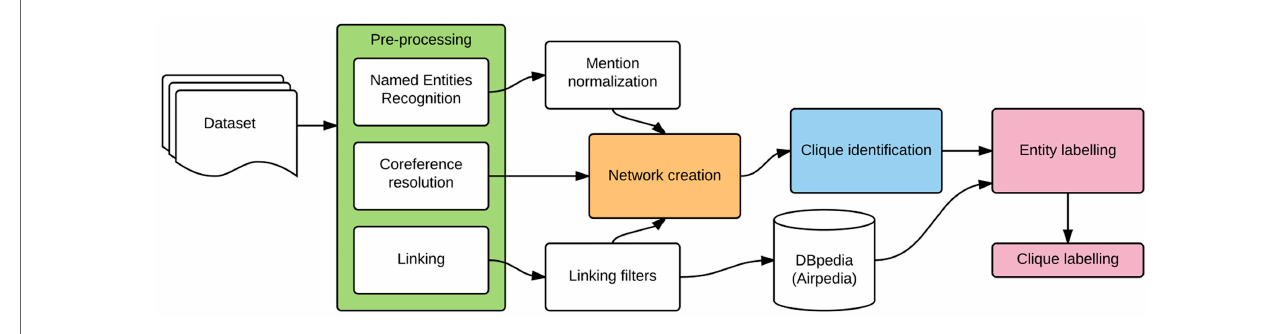
FigUre 2 | Workflow of the whole